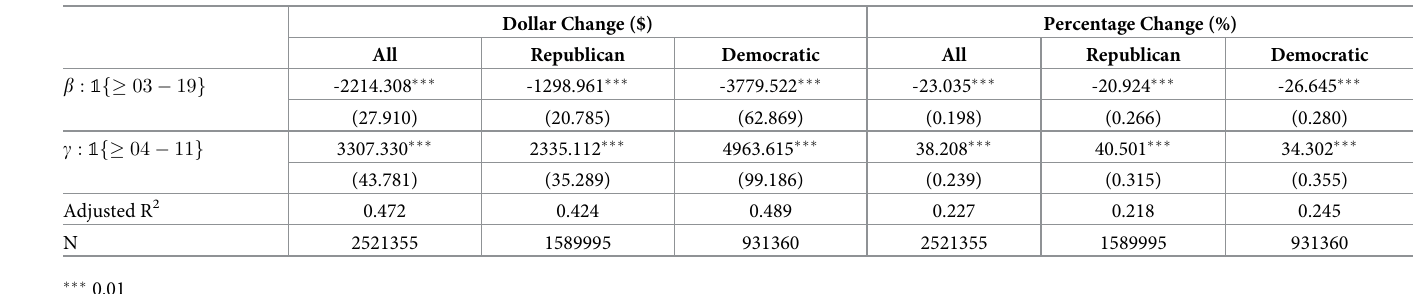
Table 1. Effects of initial lockdown and stimulus payments on zip code spending.